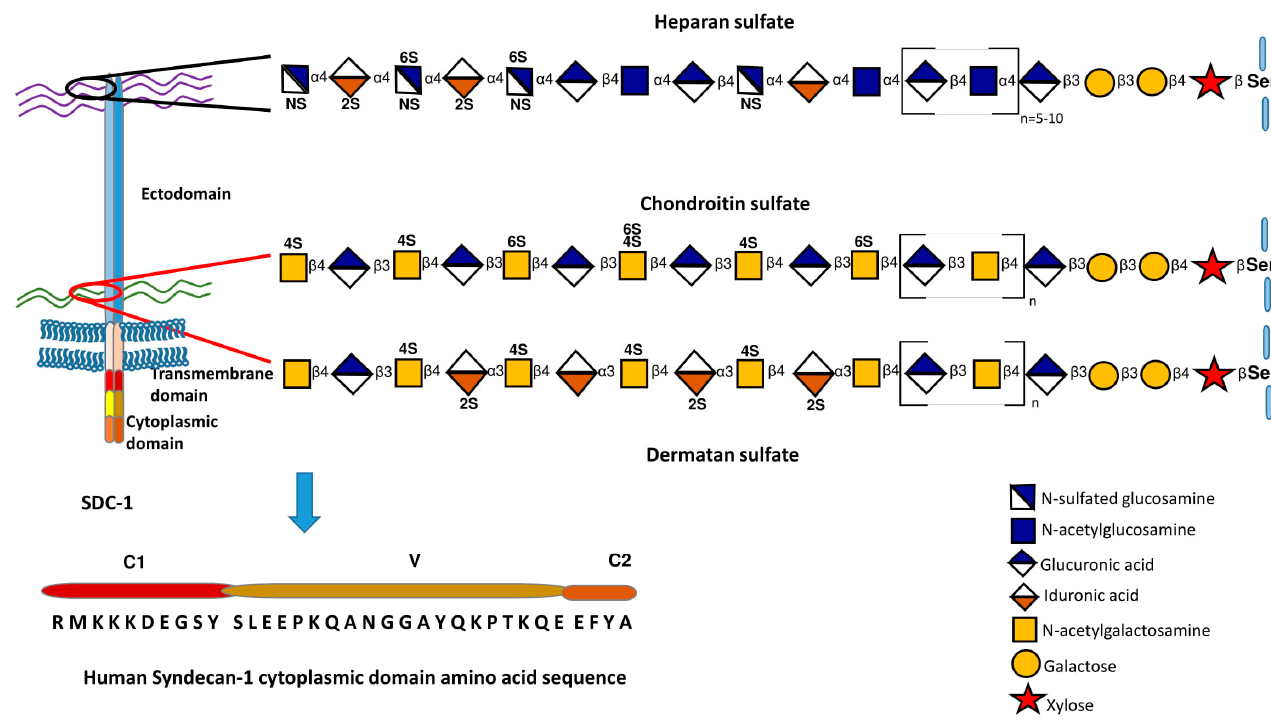
Figure 1. A schematic representation of syndecan-1 structure, cytoplasmic domain sequence and approximate location of heparan and chondroitin/dermatan sulfate chains. The synthesis of these glycosaminoglycans is also summarized. Further details of glycosaminoglycan synthesis and its regulation can be found in